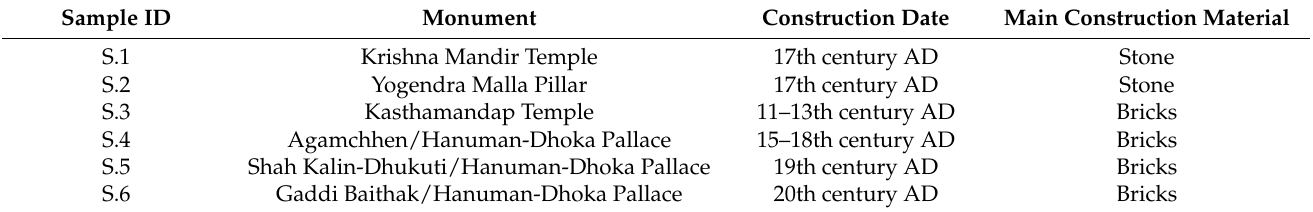
Figure 2. Illustration of the studied samples, as collected from the monumental structures. Table 1. Context of the studied samples.